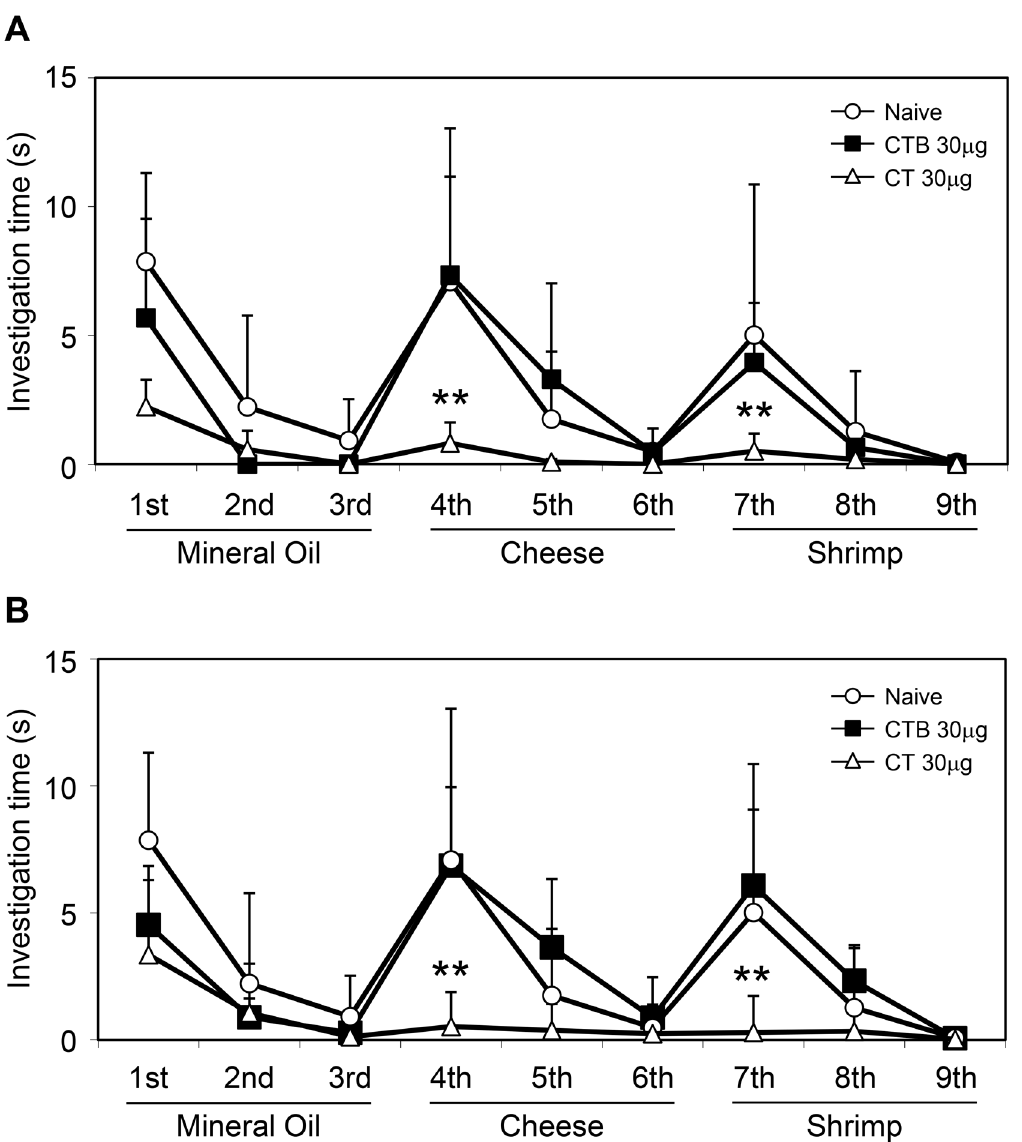
Fig 3. Habituation – dishabituation test after nasal administration of 30 μ g CTB or CT. One day (24 h, A ) or three days (72 h, B ) after nasal administration of the indicated compounds, the habituation — dishabituation test was performed with the indicated odors. Na ï ve (untreated) mice were used as controls. For each group, the time spent in investigation (mean ± 1 SD; n = 10 mice) in each experimental group during each 3-min period (with 15-min intervals) is shown. ** P < 0.01 (one-way ANOVA followed by the Dunnett test) compared with value for na ï ve mice or mice after nasal administration of